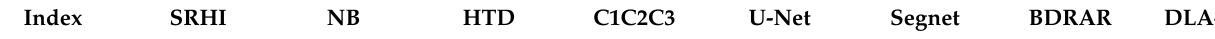
Table 7. Average shadow-detection F values of different shadow-detection methods.